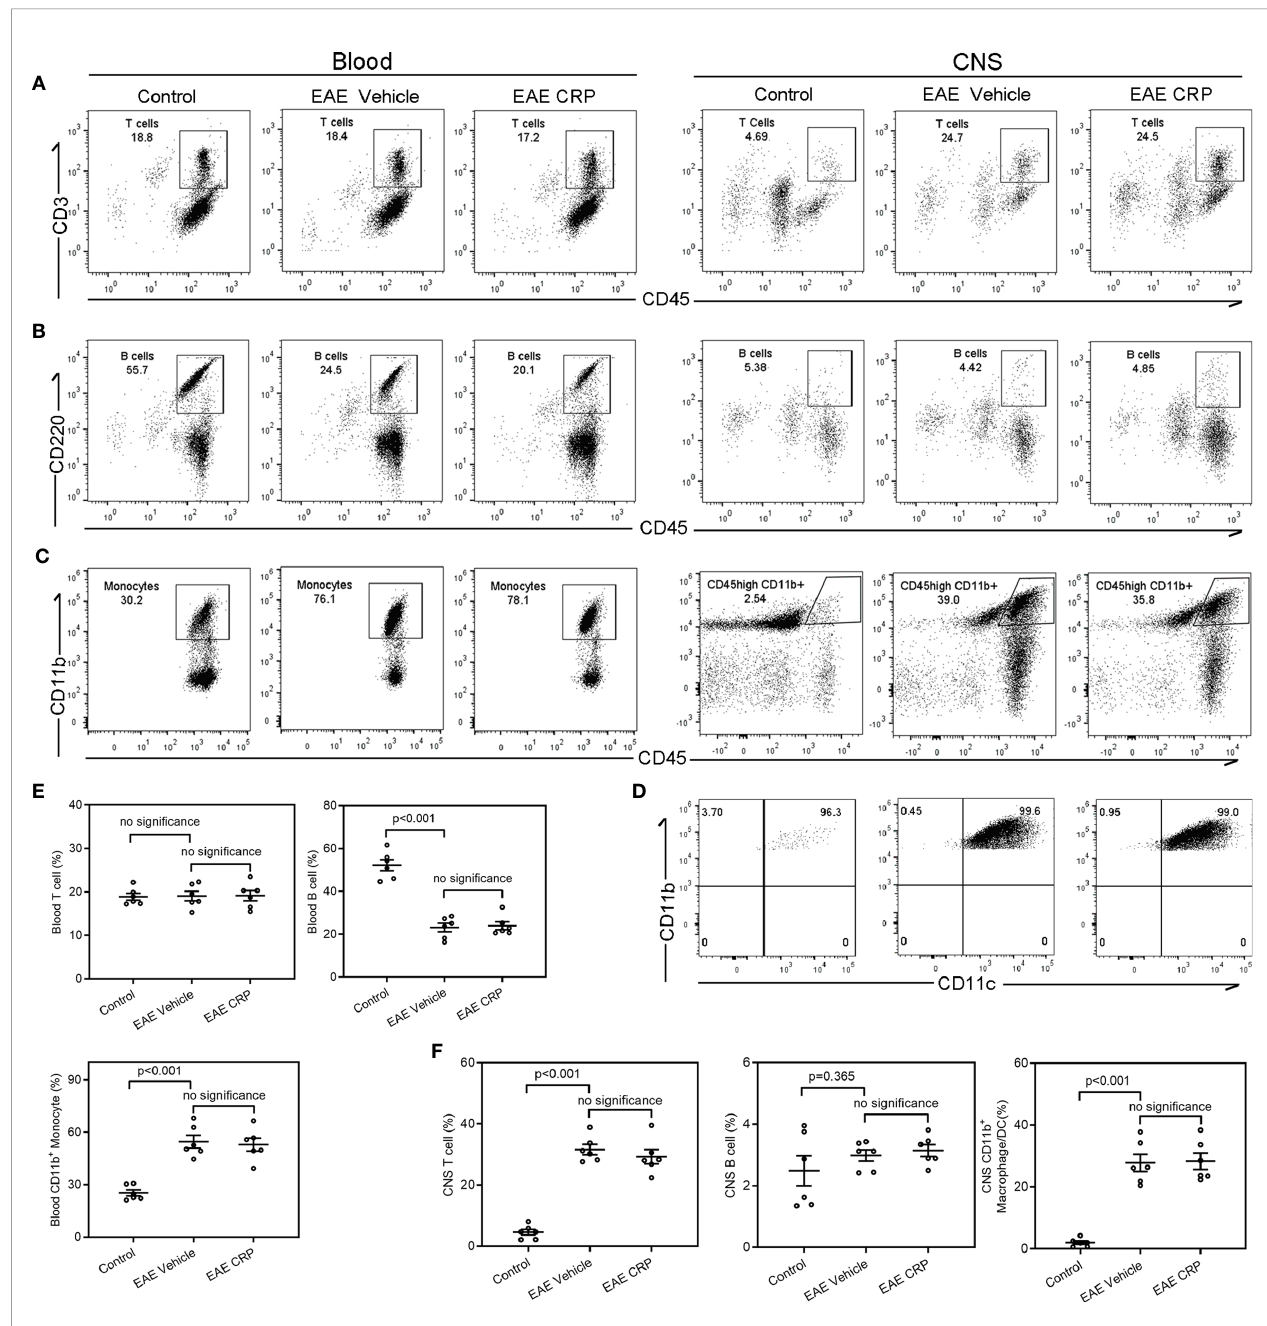
FIGURE 3 | Analysis of immune cell composition of blood and CNS during the effector phase of EAE in WT mice.Flow cytometry of T cells (A) , B cells (B) and monocytes (C) in the blood and CNS from WT control mice, WT EAE vehicle mice and WT EAE CRP mice (n = 6). (D) The CNS-in fi ltrating CD45 high CD11b + myeloid cells were proved to be CD11b + CD11c + DCs. (E) The quantitative and statistical analyses of the immune cells in blood were presented (n = 6). (F) The quantitative and statistical analyses of the immune cells in CNS were presented (n = 6). Data are presented as mean ± SEM; p < 0.05 was considered statistically signi fi cant. ns, no signi fi